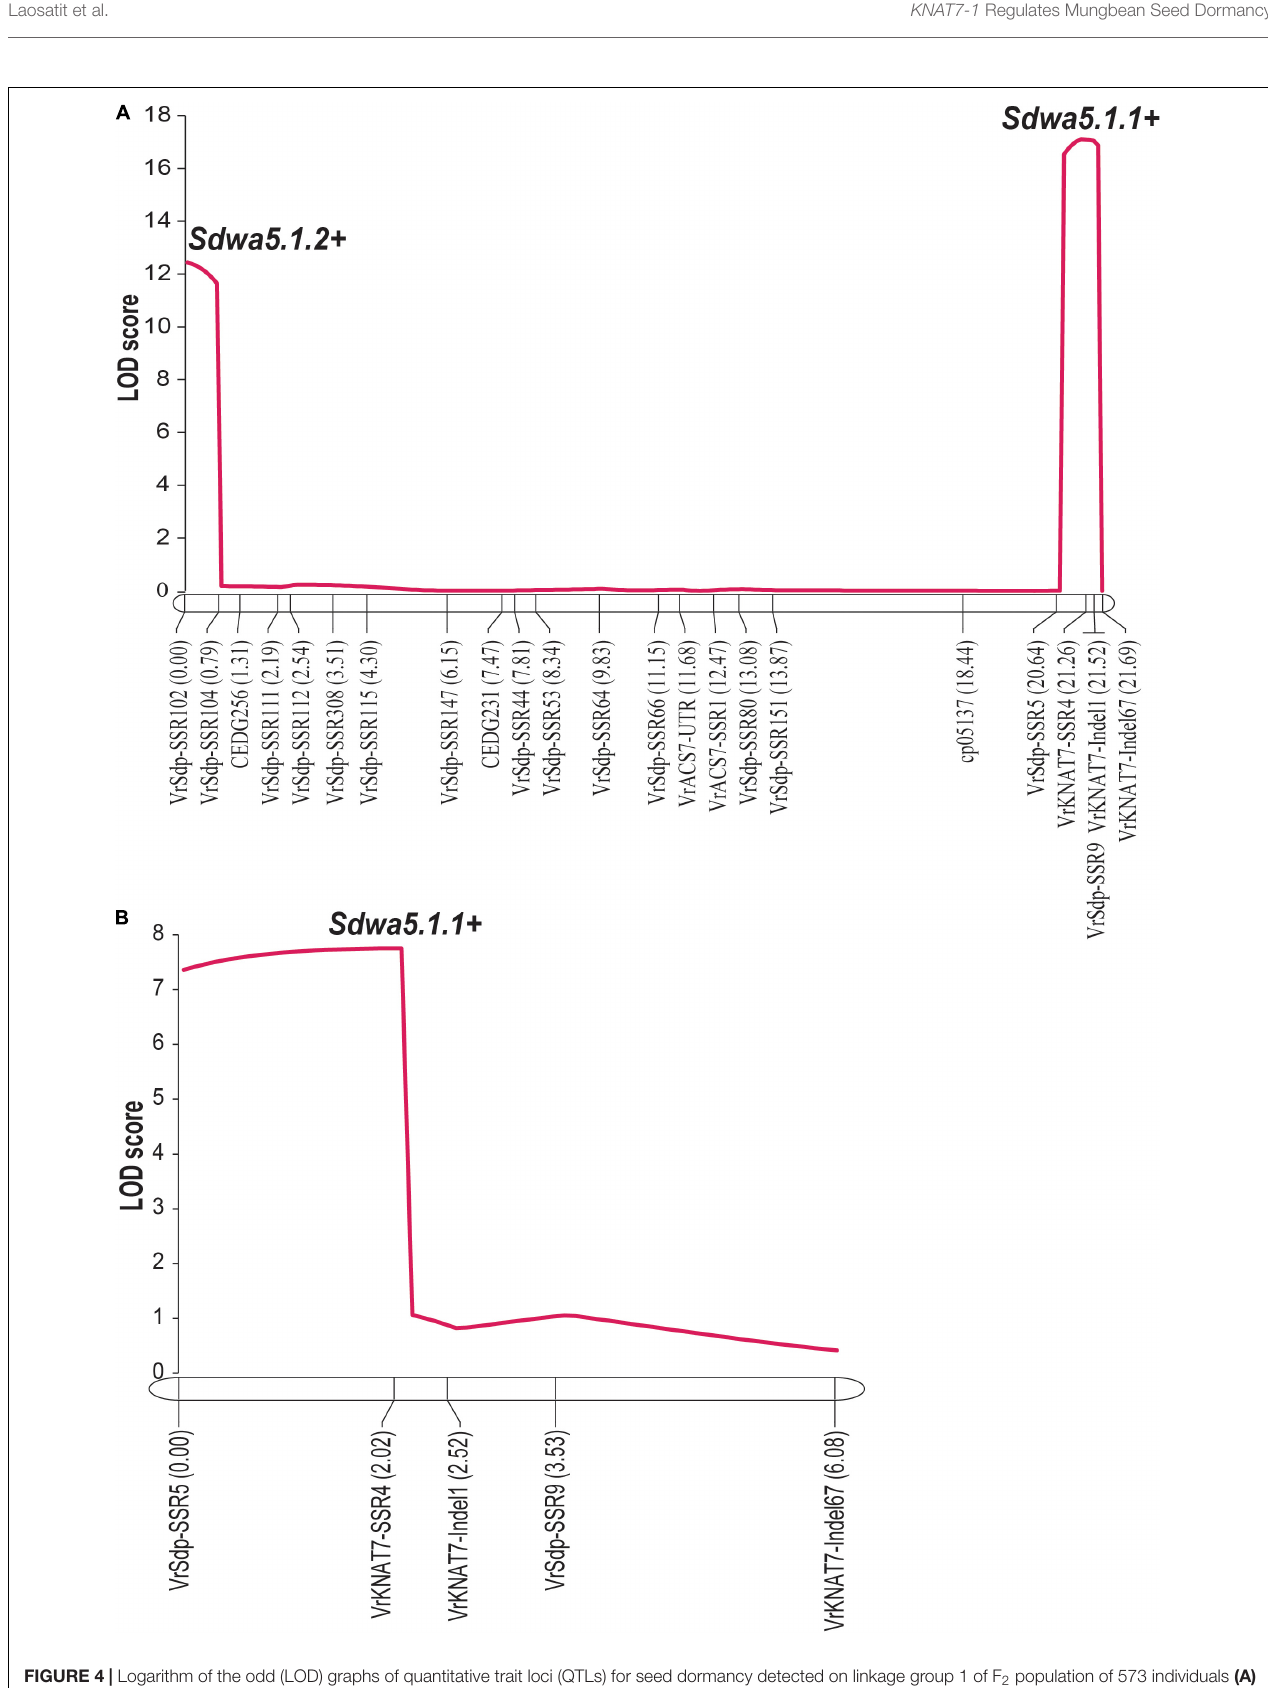
Frontiers in Plant Science |